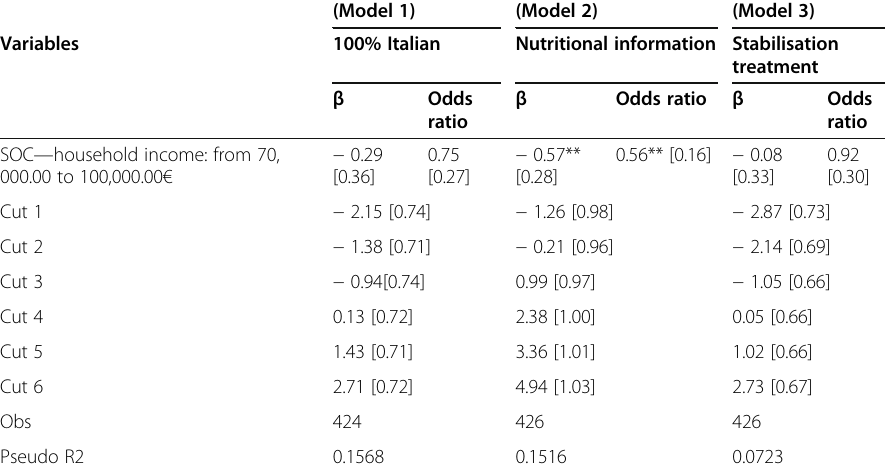
Table 3 Model estimation: beta coefficients and odds ratio for mandatory label disclosure